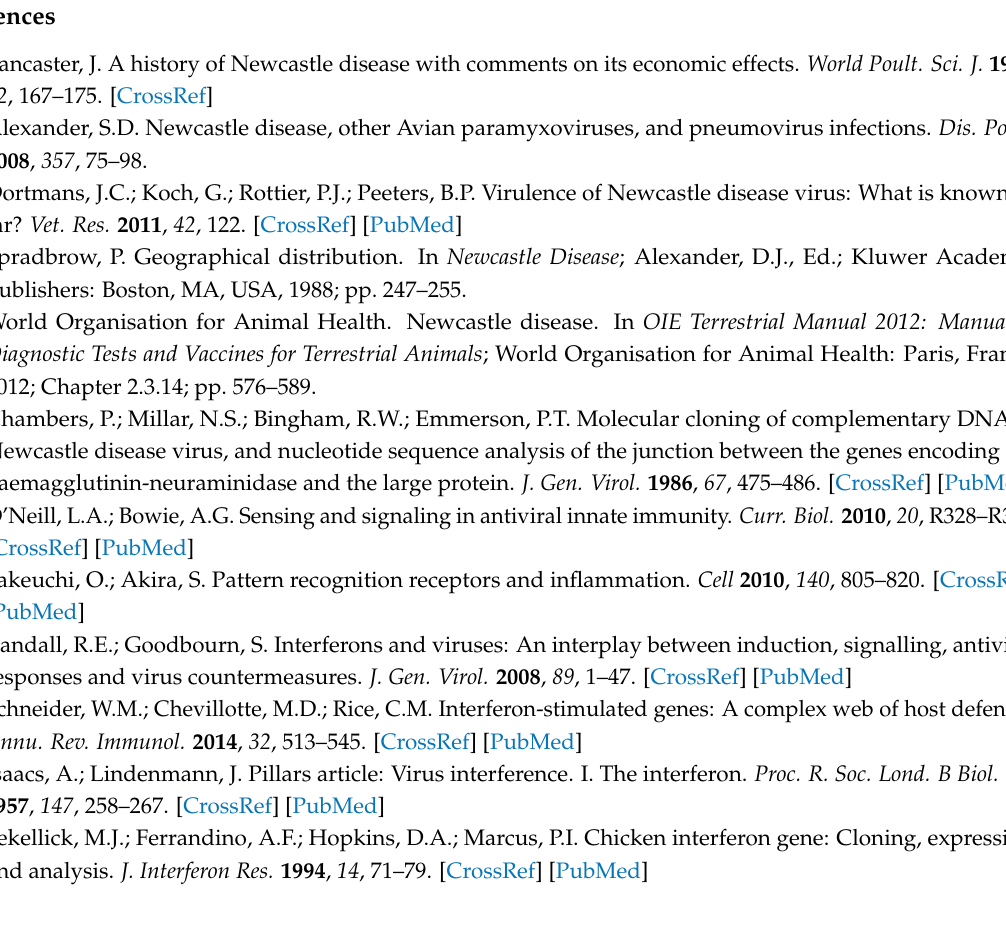
Table S1: Differentially expressed transcripts in Herts/33_vs_blank (Table S1A), LaSota_vs_blank (Table S1B) and common in both strains (Table S1C), Table S2: Differentially expressed ISGs in Herts/33_vs_blank (Table S2A), LaSota_vs_blank (Table S2B) and common in both strains (Table S2C). Acknowledgments: This research was financially supported by the National Natural Science Foundation of China (No. 31530074) and Agricultural Science and Technology Innovation Program (ASTIP) of the Chinese Academy of Agricultural